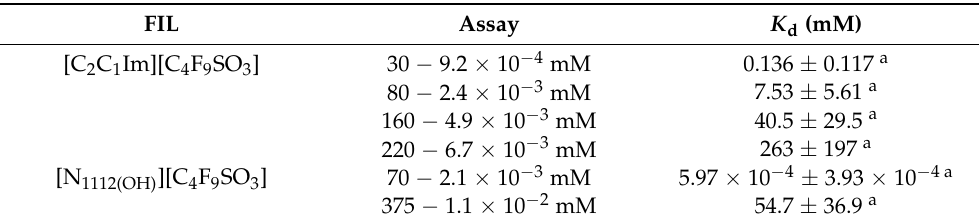
Table 2. Determined dissociation constants K d by the analysis of the fitting of the MST dose-curve re-